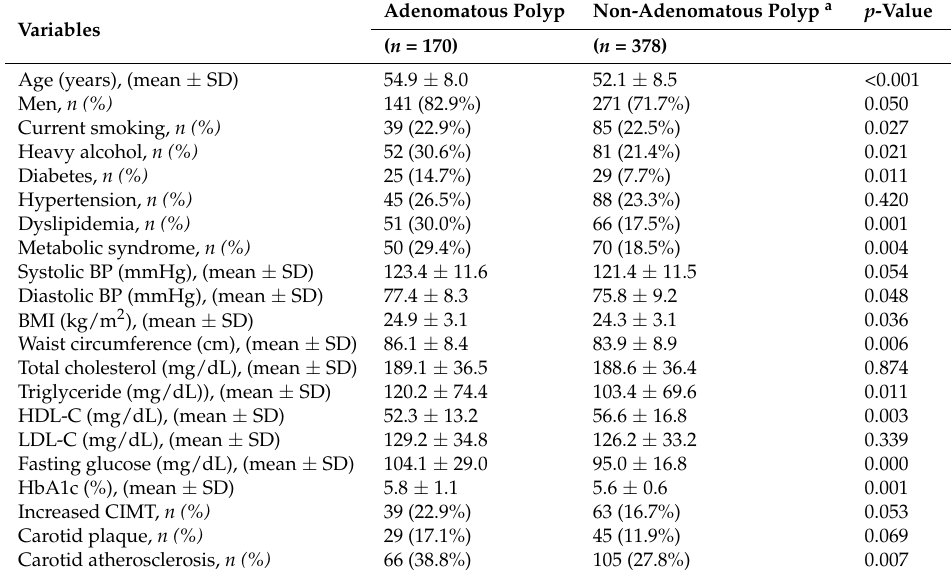
Table 1. General characteristics of subjects according to colorectal adenomatous